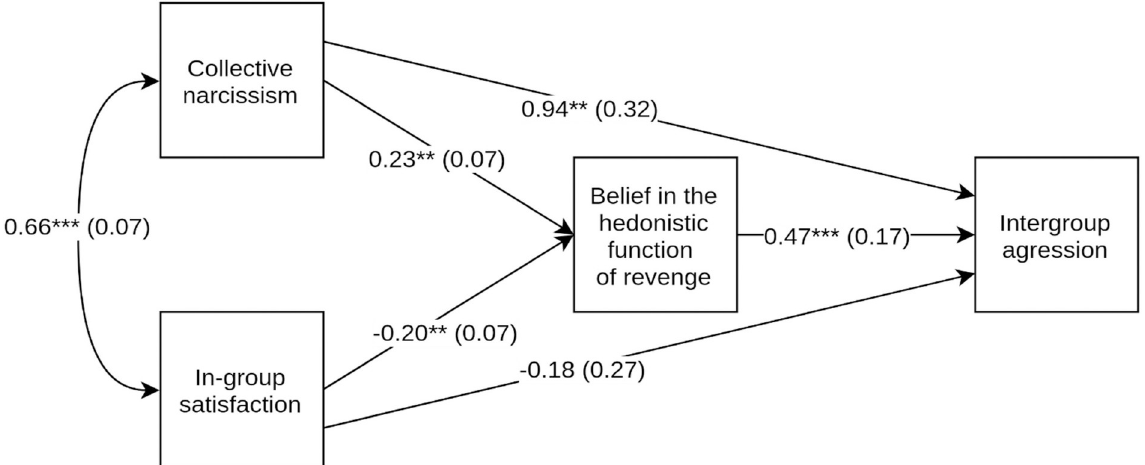
Fig 2. Unstandardized path coefficients, Study 2. �� p < .01; ��� p < .001.